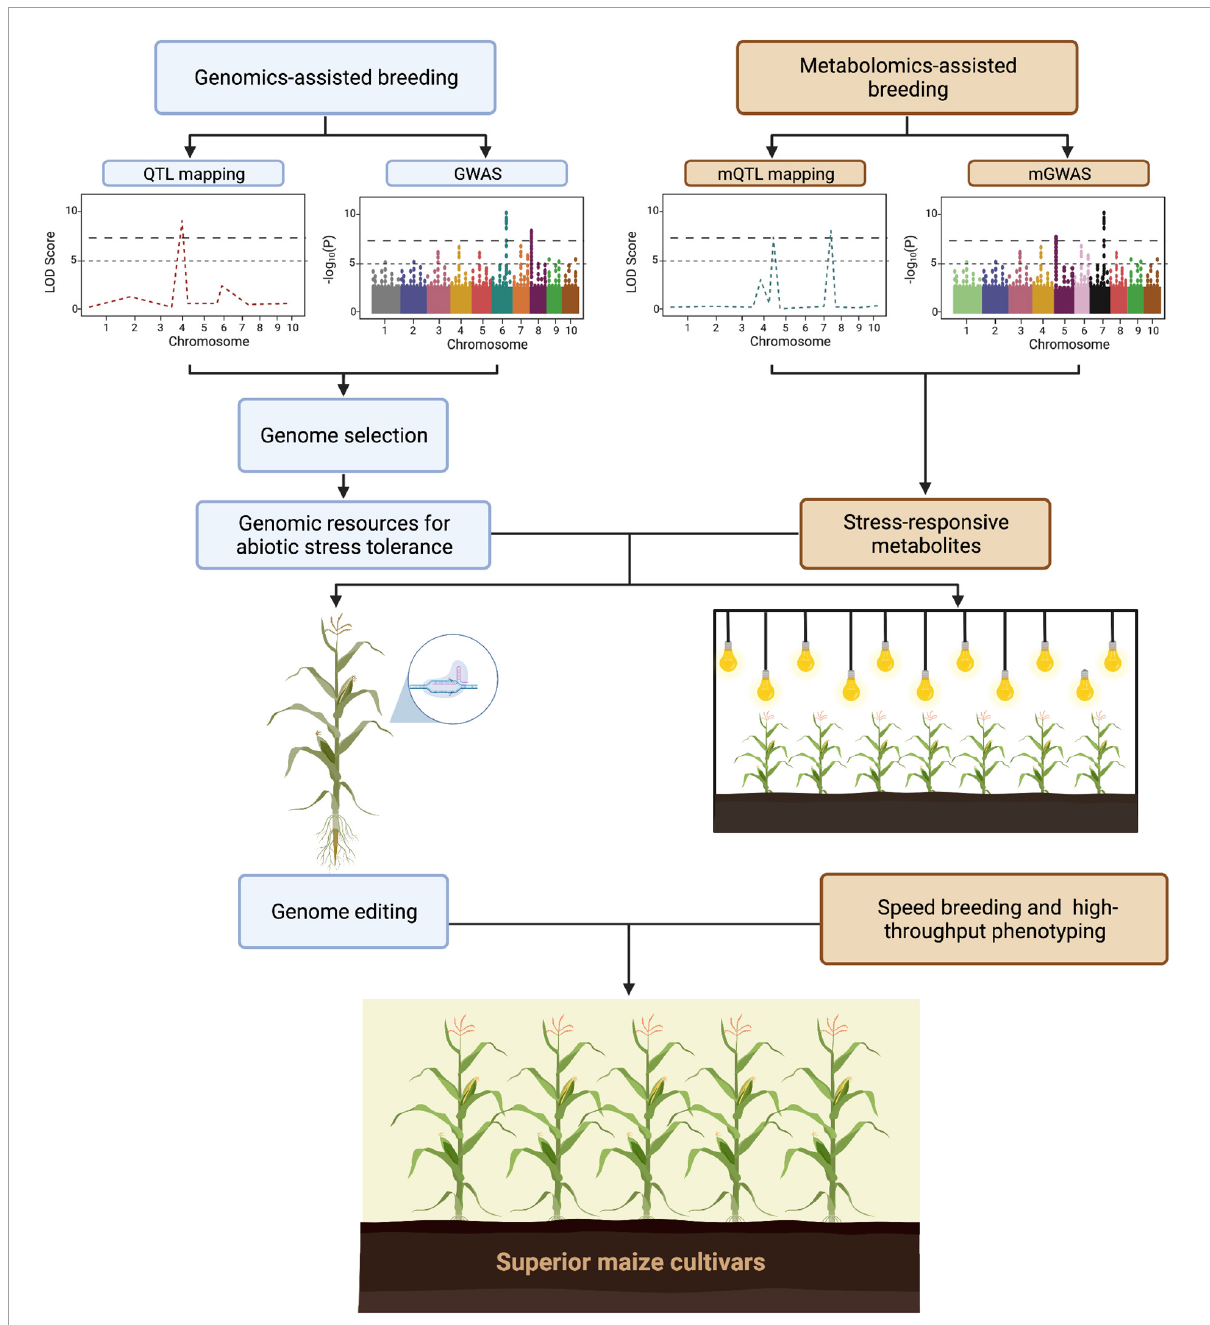
FIGURE2 General workflow on the utilization of omics technologies in development of superior maize cultivars (https://biorender.com; accessed on 21 February 2022).